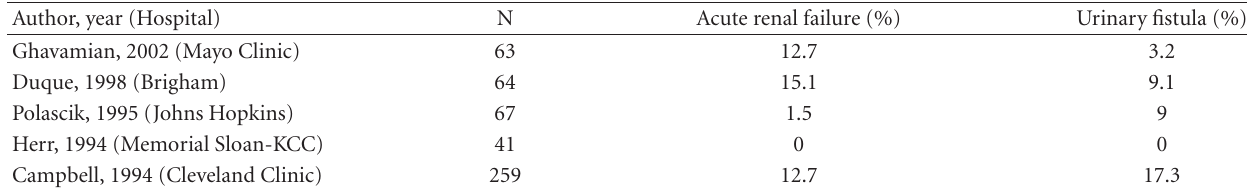
Table 2: Complications after open partial